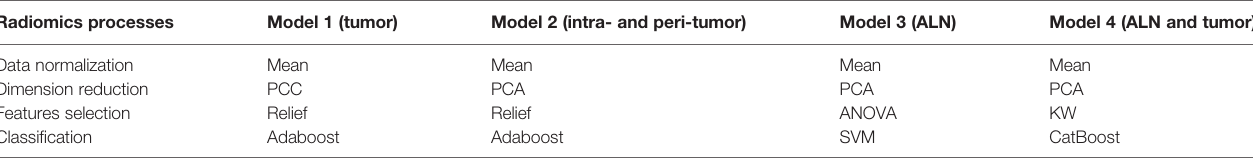
TABLE 2 | Construction process of the radiomics models.